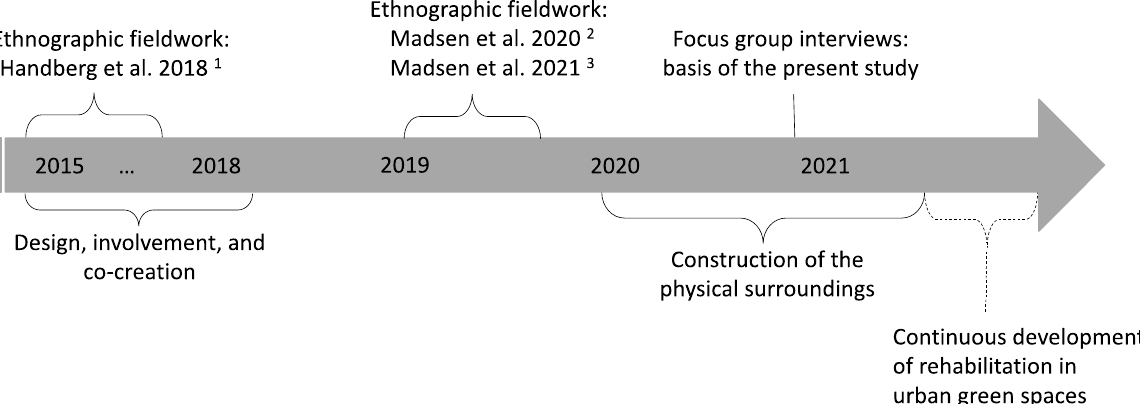
Figure 1. SPARK park timeline. 1 Handberg, C.; Mygind, O.; Johansen, J.S. Lessons learnt on the meaning of involvement and co-creation in developing community-based rehabilitation. Disabil. Rehabil. 2018 [25]. 2 Madsen, L.S.; Nielsen, C.V.; Oliffe, J.L.; Handberg, C. Navigating a Middle Ground—Exploring Health Professionals’ Experiences and Perceptions of Providing Rehabilitation in Outdoor Community Settings. Qual. Health Res. 2020 [24]. 3 Madsen, L.S.; Jakubec, S.L.; Nielsen, C.V.; Handberg, C. The potential of outdoor contexts within community-based rehabilitation to empower people with disabilities in their rehabilitation. Disabil. Rehabil. 2021 [18].